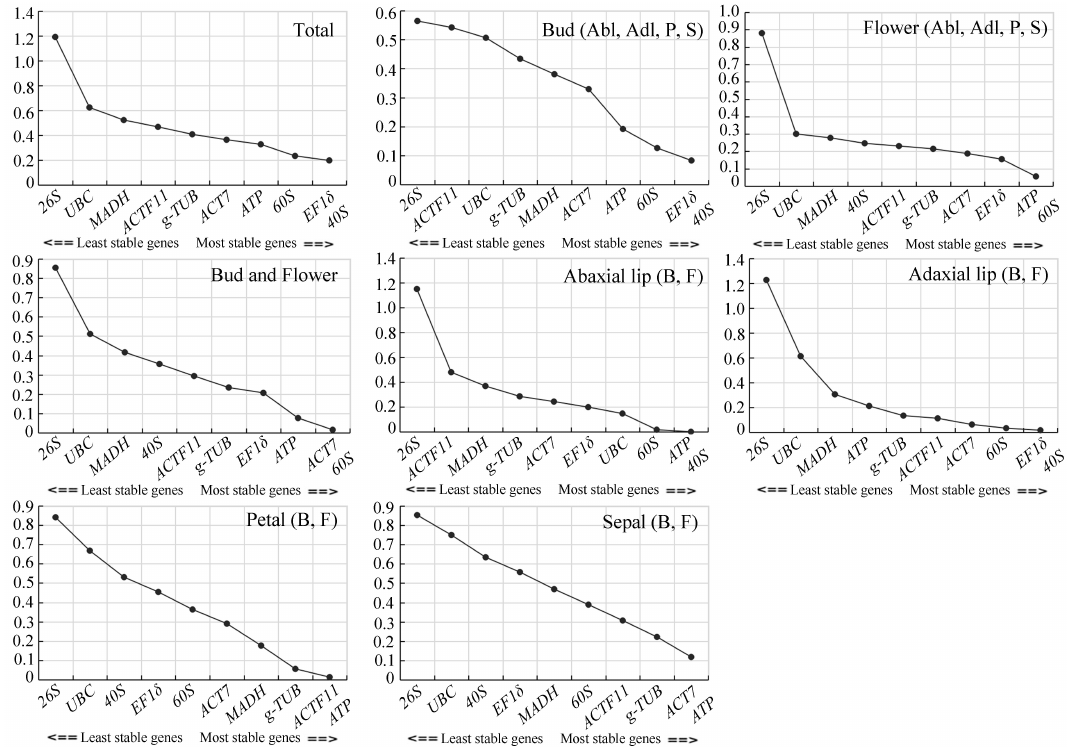
Figure 3. Average expression stability (M value) of 10 candidate reference genes calculated by geNorm software. Expression stability was evaluated in different sample